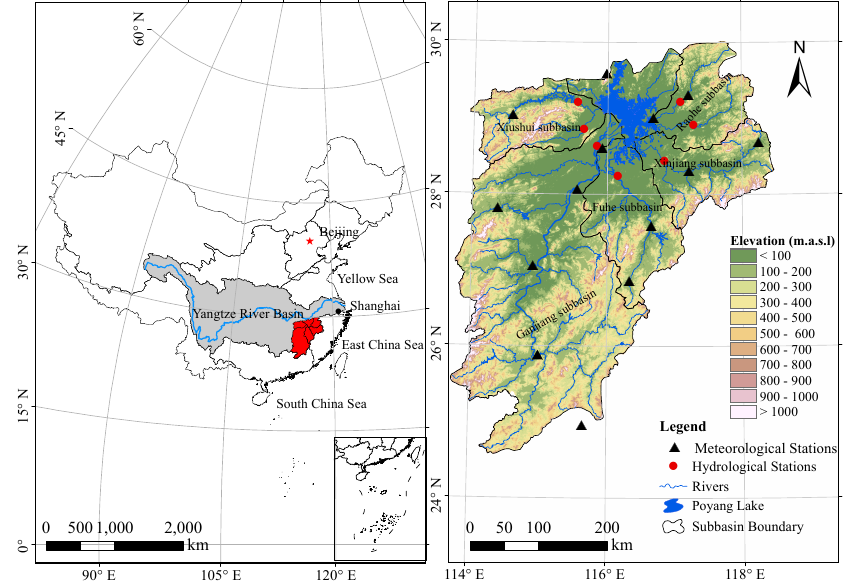
Figure 1. Topography and river networks of PYLB. Locations of the 14 meteorological stations and seven hydrological stations are presented using black triangles and red dots,